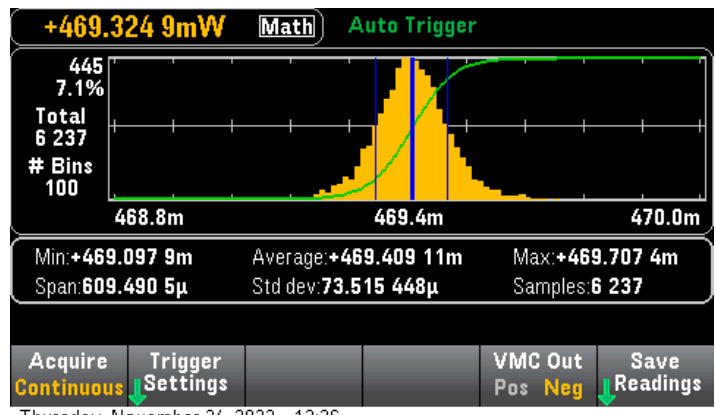
Figure 6. STM32H7 Idle consumption on Arduino